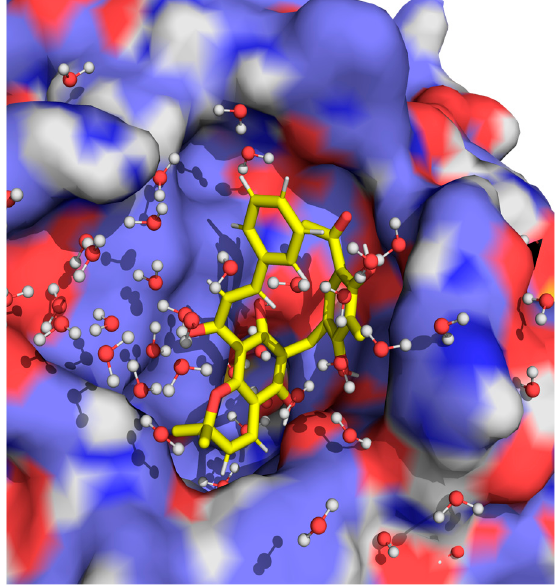
Figure 8. Representation of the spatial region typically occupied by RoT when interacting with the extracellular surface of AQP3, near the selectivity filter.